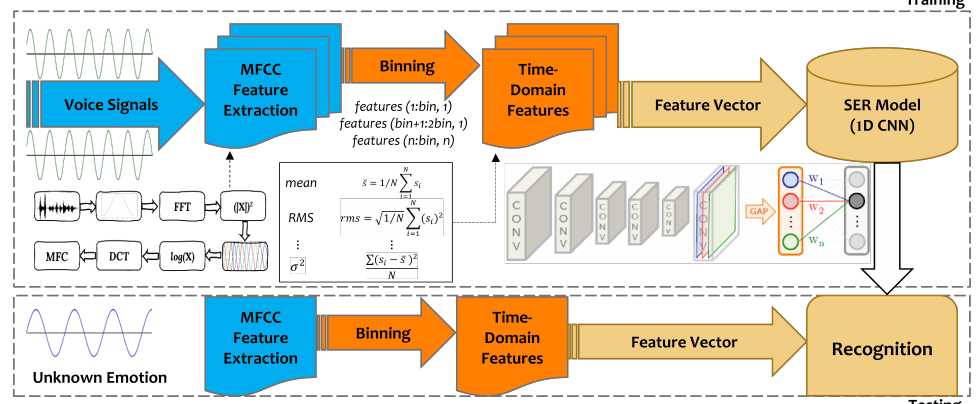
Figure 2. Proposed research methodology for